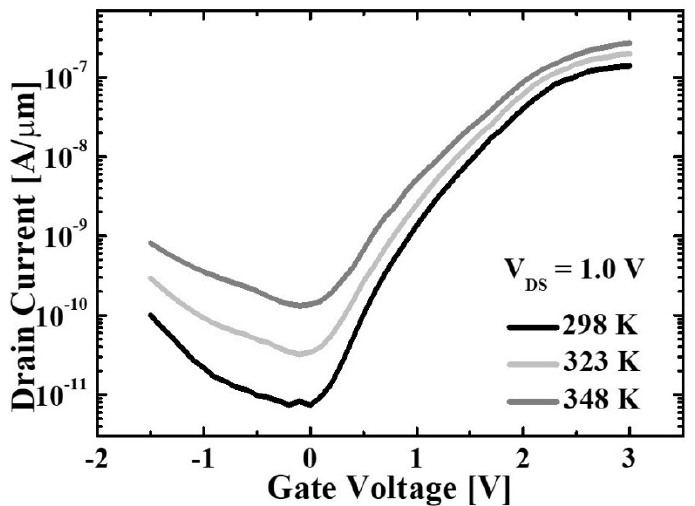
Figure 8. Transfer characteristics of the proposed TFET and conventional planar TFETs with Si and SiGe channels.